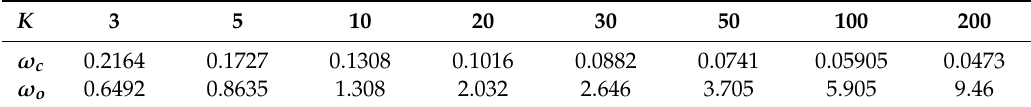
Table 1. Upper Limit of ω c for Di ff erent K